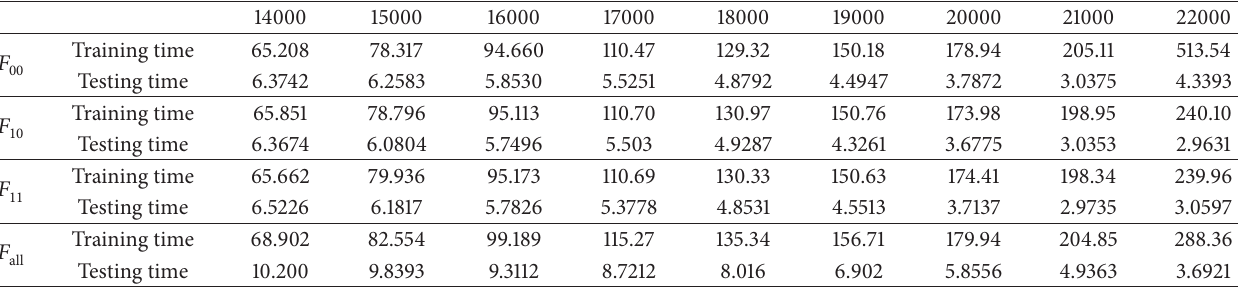
Table 4: The training and testing time under different sample sizes (in